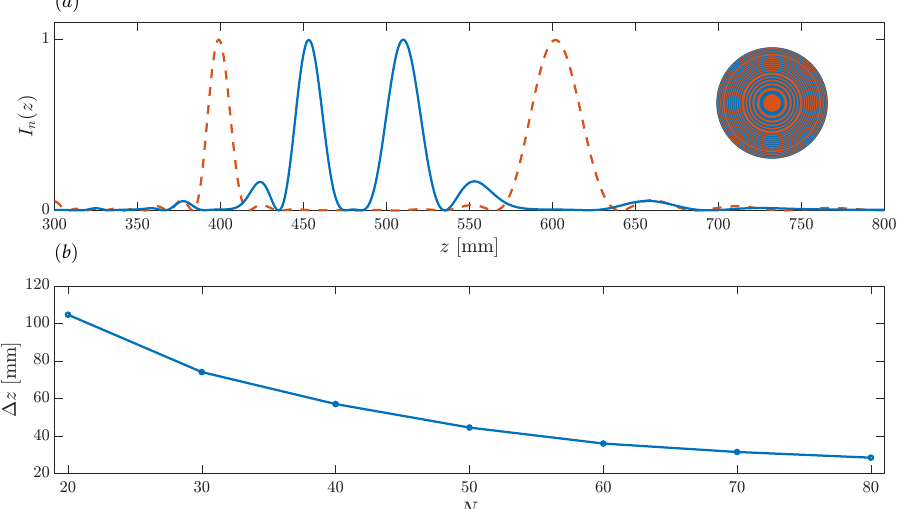
Figure 8. ( a ) Bifocal ZP focusing profiles vs. axial coordinate. Blue solid line: resolution limit case with u 1 = 22 and u 2 = 20. Dashed red line: initial design example with u 1 = 25 and u 2 = 17. Inset depict the ZP layout for the resolution limit case. ( b ) Resolution limit against N .